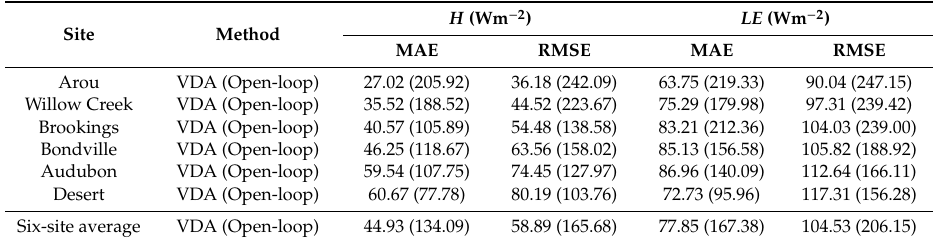
Table 5. MAE and RMSE of half-hourly H and LE estimates from the VDA and open loop approaches at the six experimental sites.